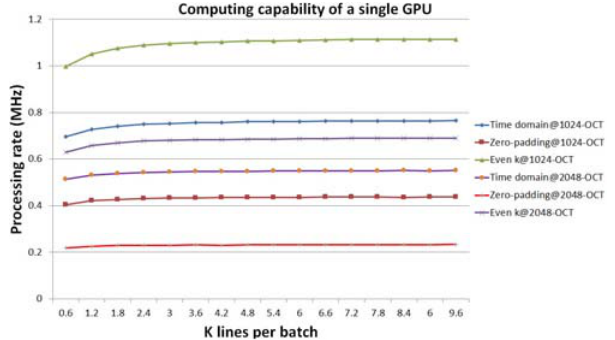
Fig. 2. Computing capability of a single